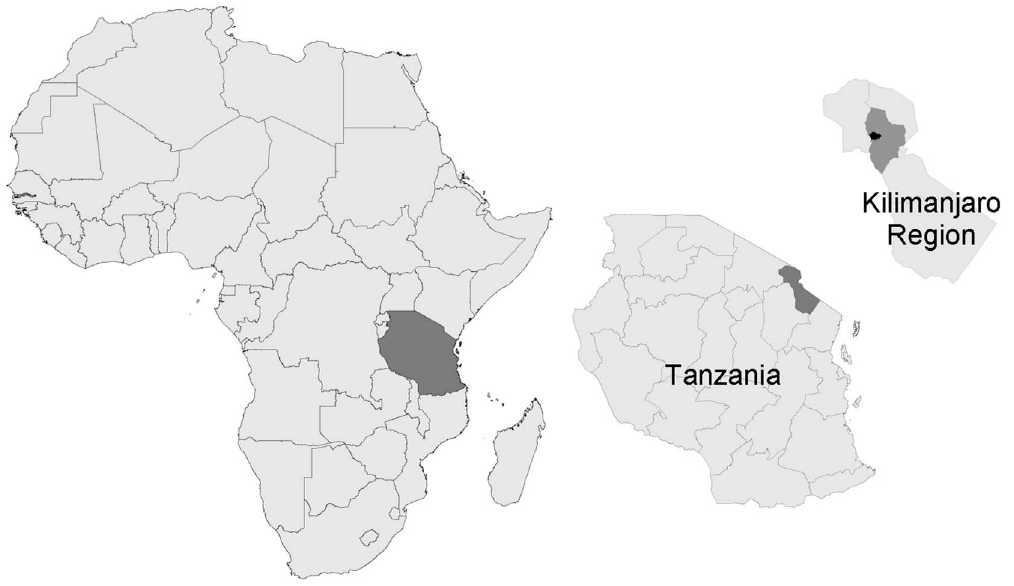
Figure 1. Africa, Tanzania and Kilimanjaro Region. Moshi Rural District shown in dark gray and Moshi Urban District in black in the Kilimanjaro Region inset.